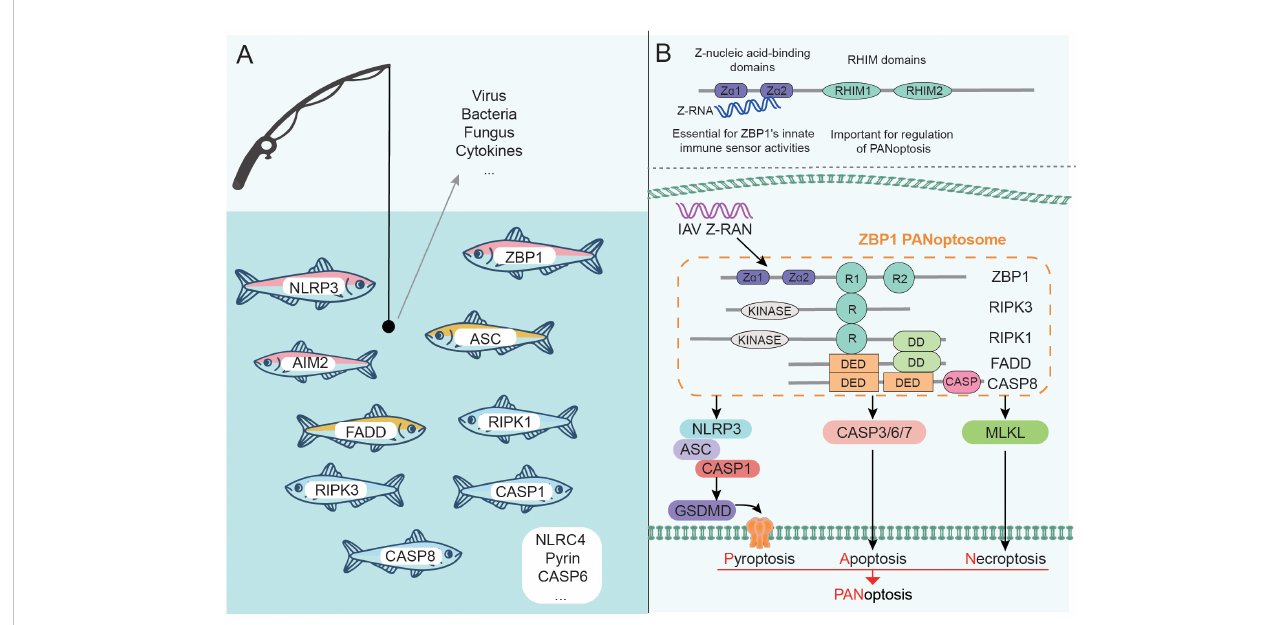
FIGURE 2 Components of PANoptosome and PANoptosis mediated by ZBP1 PANoptosome. (A) Many proteins can participate in the assembly of PANoptosome. The complex induced by different factors may be different, but it generally contains sensors, adapters, and effectors. (B) ZBP1 contains Z a and RHIM domains and is a representative sensor. A variety of proteins form ZBP1 PANoptosome through the interaction between domains, which can trigger the occurrence of